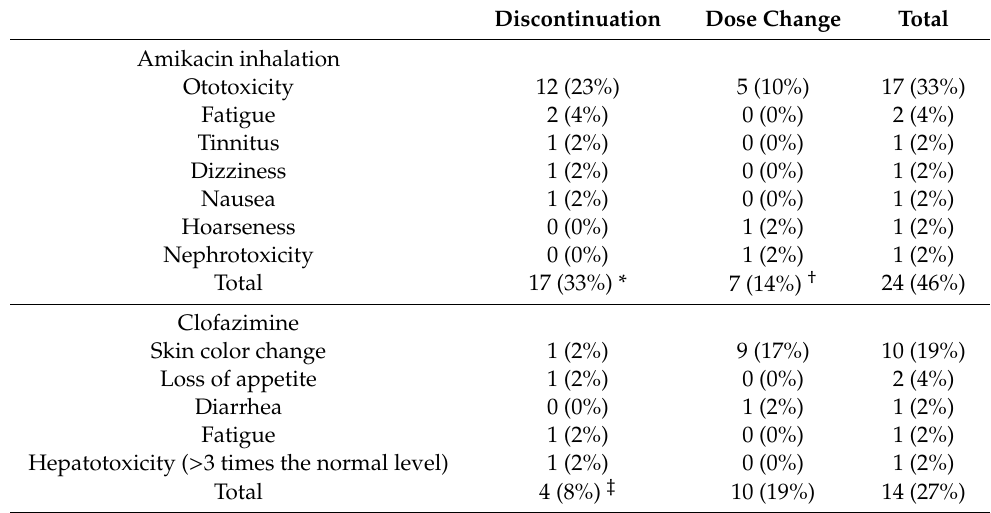
Table 4. Adverse e ff ects associated with inhaled AMK and CFZ therapy in 52 study